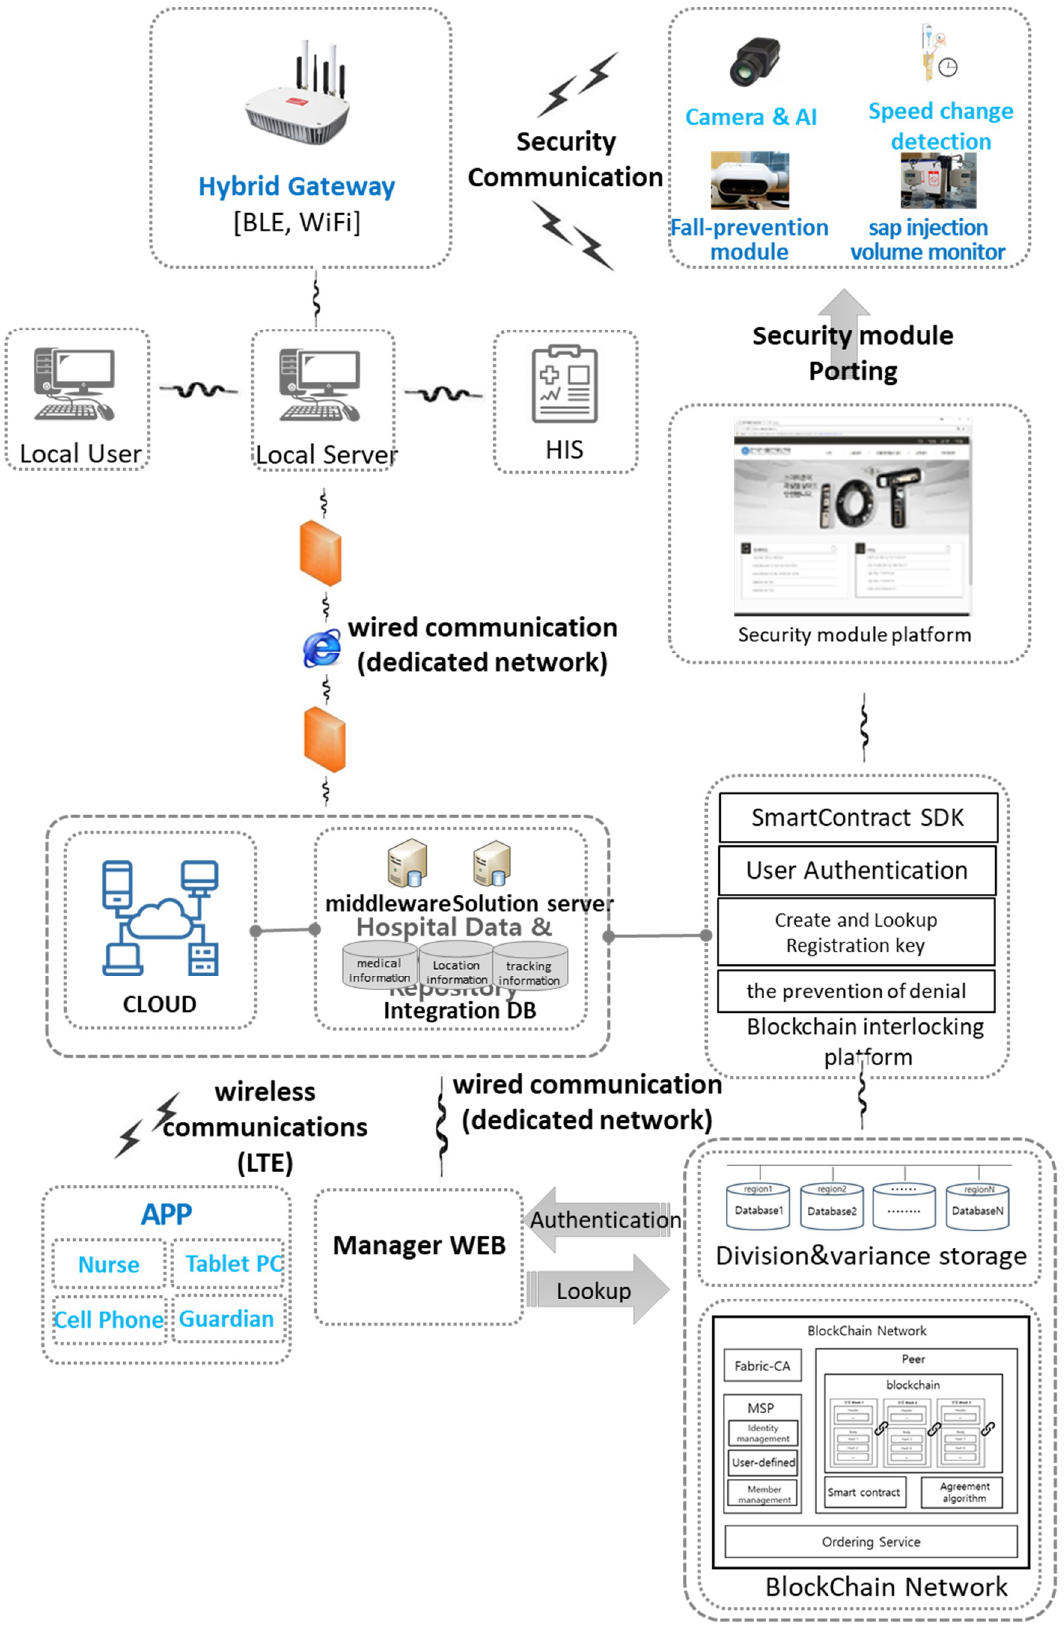
Figure 2. Blockchain Certification System.